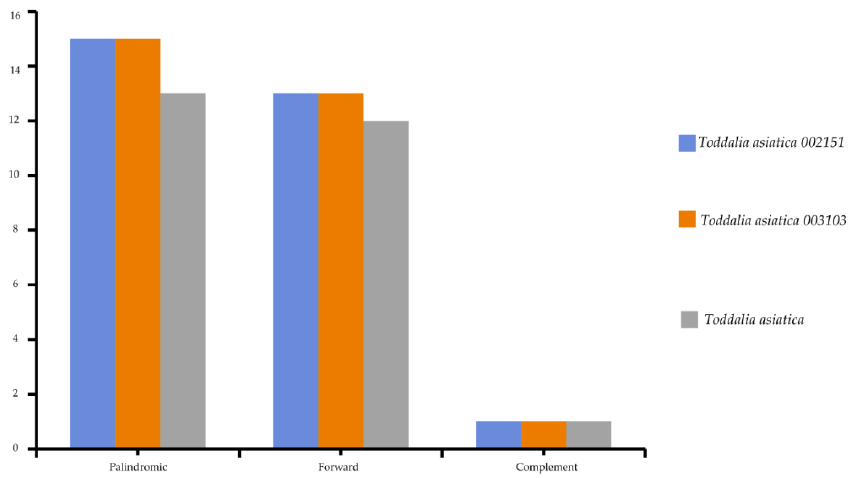
Figure 4. Total number of repeats found in Toddalia